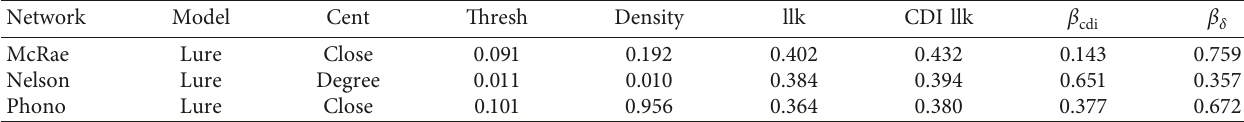
Table 2: Best performing models on each of the network representations.